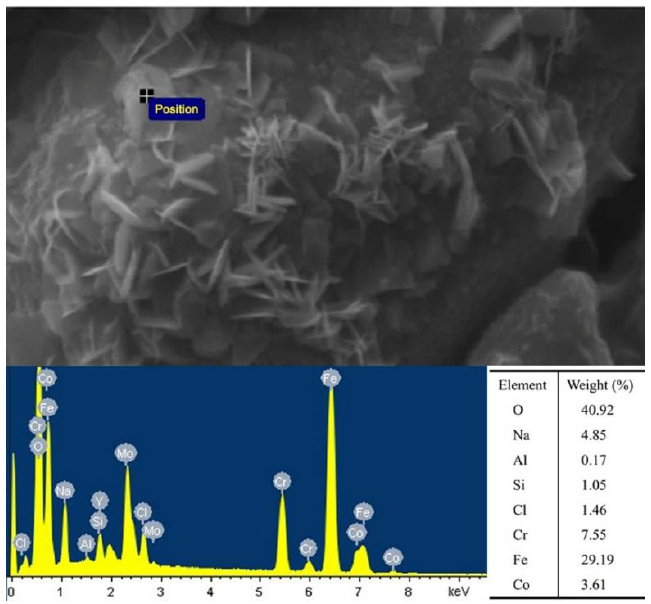
Figure 14. Energy dispersive spectrometry of the grains on the particle surface.